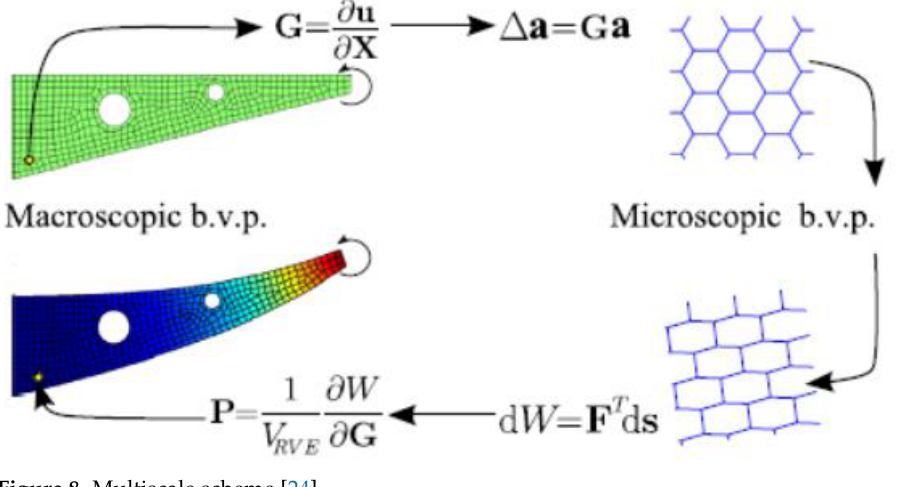
Figure 8. Multiscale scheme